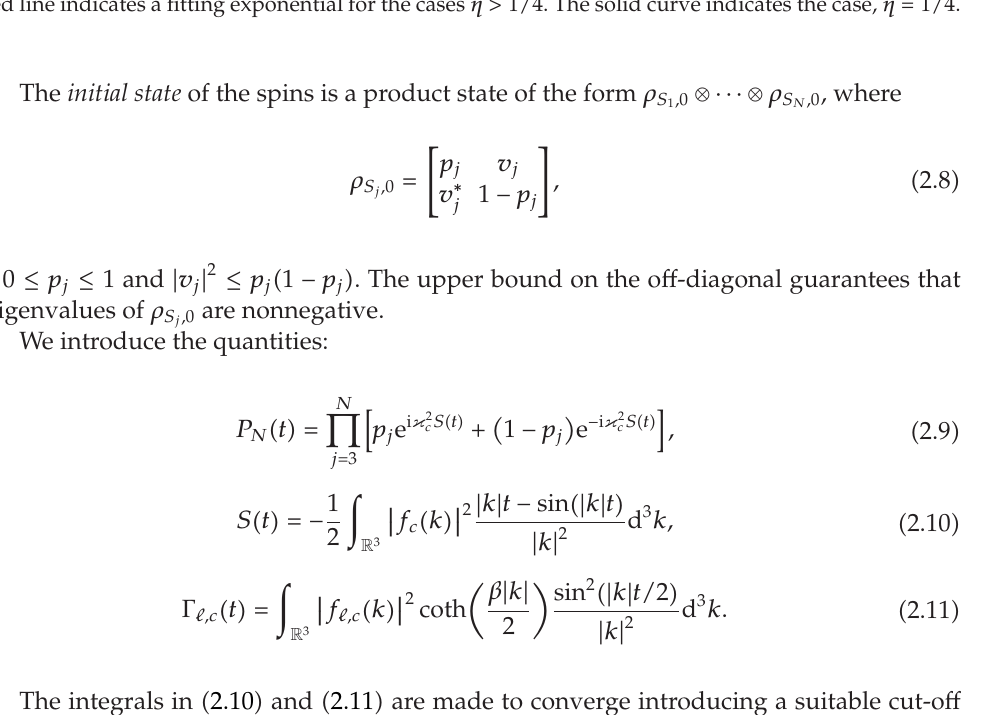
The initial state of the spins is a product state of the form ρ S